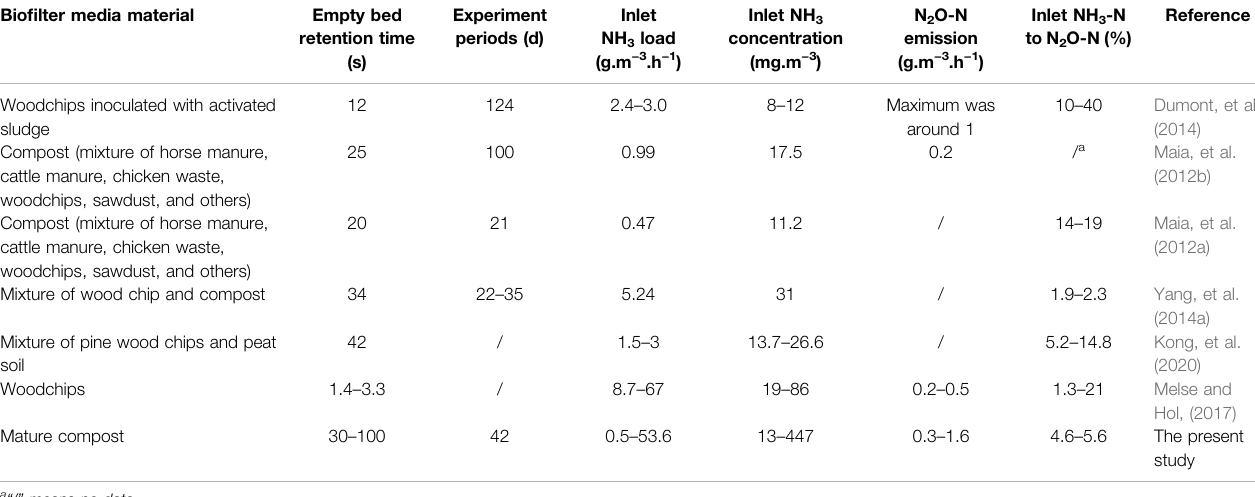
TABLE 2 | Literature overview of N 2 O generations in bio fi lters.